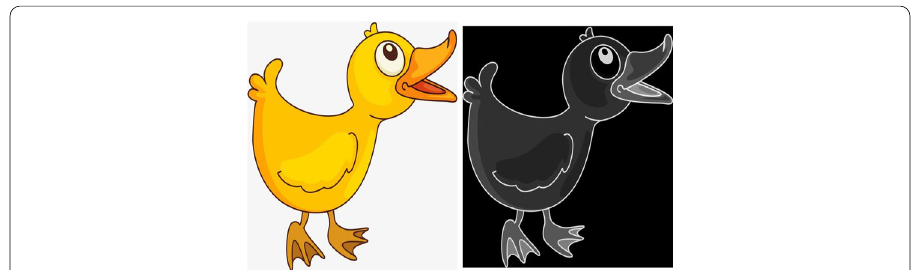
Fig. 3 The saliency map obtained by the LC algorithm area